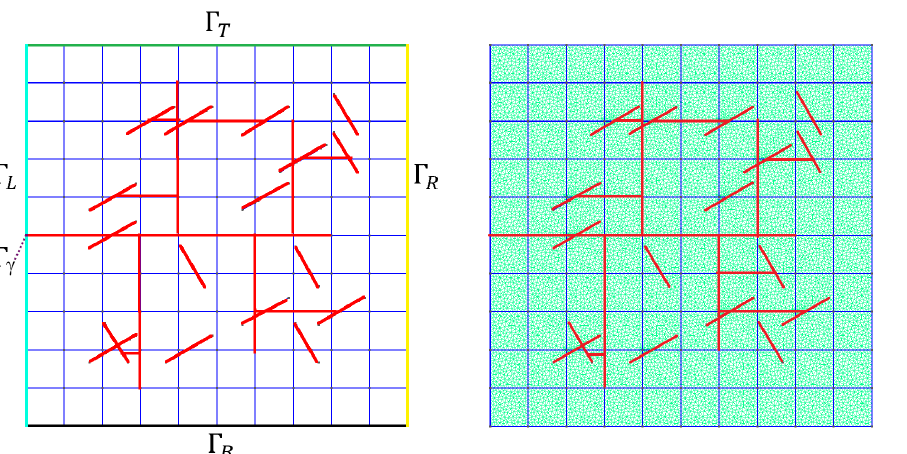
Figure 7. Computation domain and grids. Coarse grid (blue color), fine grid (green), and frac- tures (red).